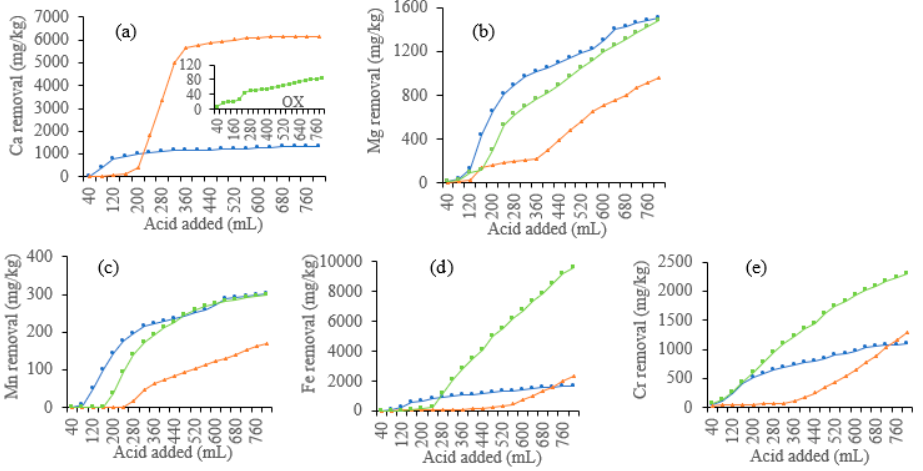
Figure 4. Cumulative removal of metals from the soils leached by di ff erent acids. ( a ) Ca, ( b ) Mg, ( c ) Mn, ( d ) Fe, ( e )